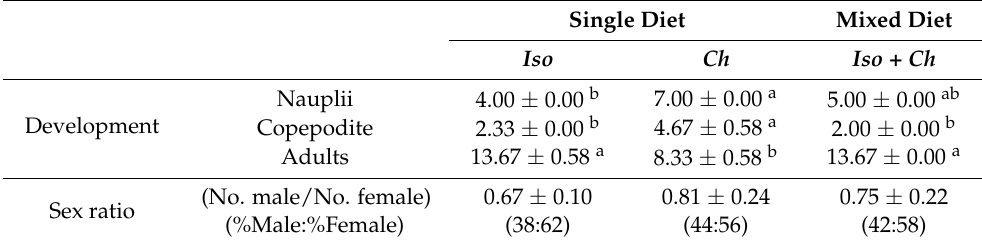
Table 5. Oithona nana development time by stage (days) as nauplii, copepodites and adults fed with single and mixed diets during 20 days of evaluation, and sex ratio of